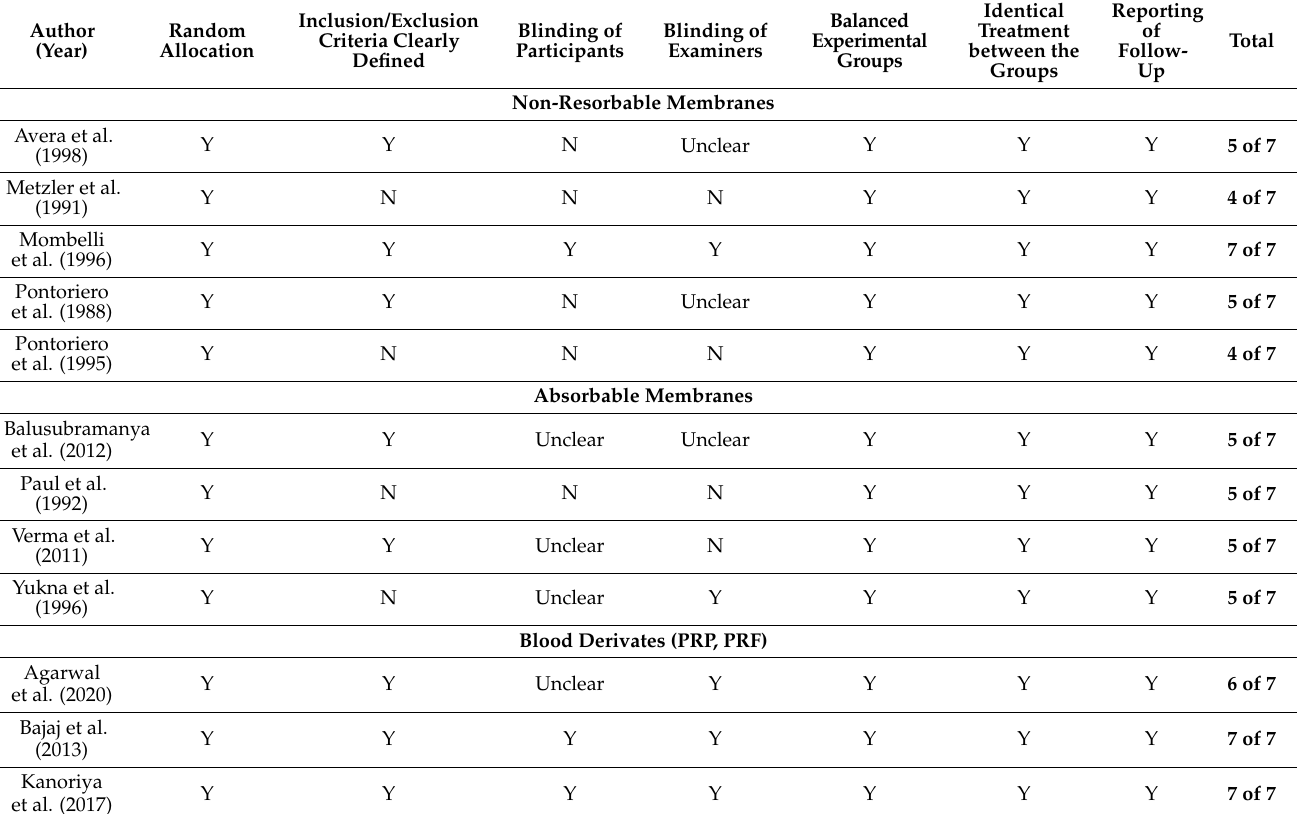
Table 1. Risk of bias summary: review authors’ judgement about each risk of bias item presented across all included